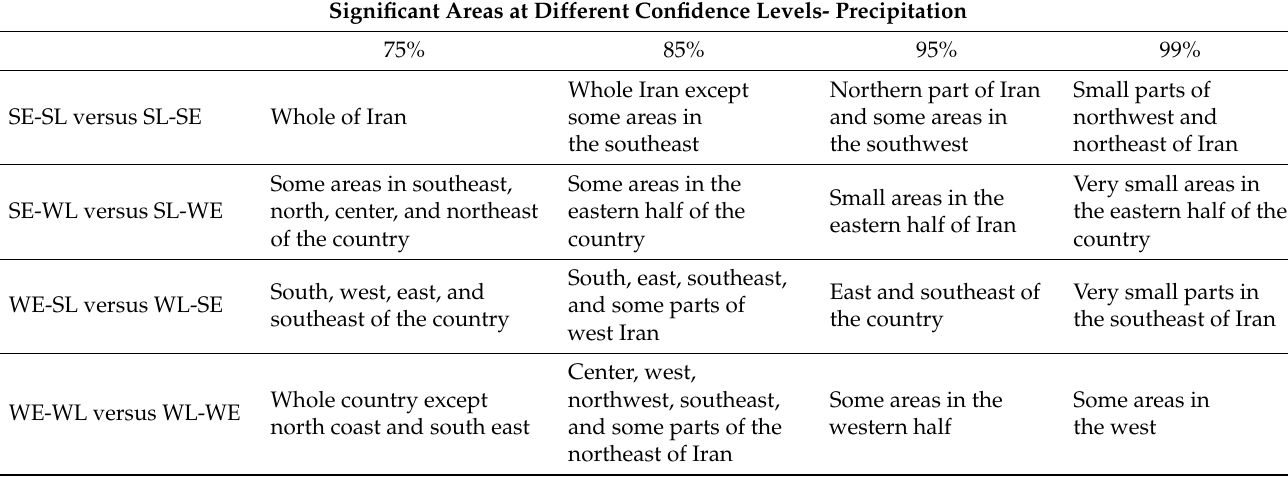
Table 6. Areas of statistically significant differences in precipitation at different confidence